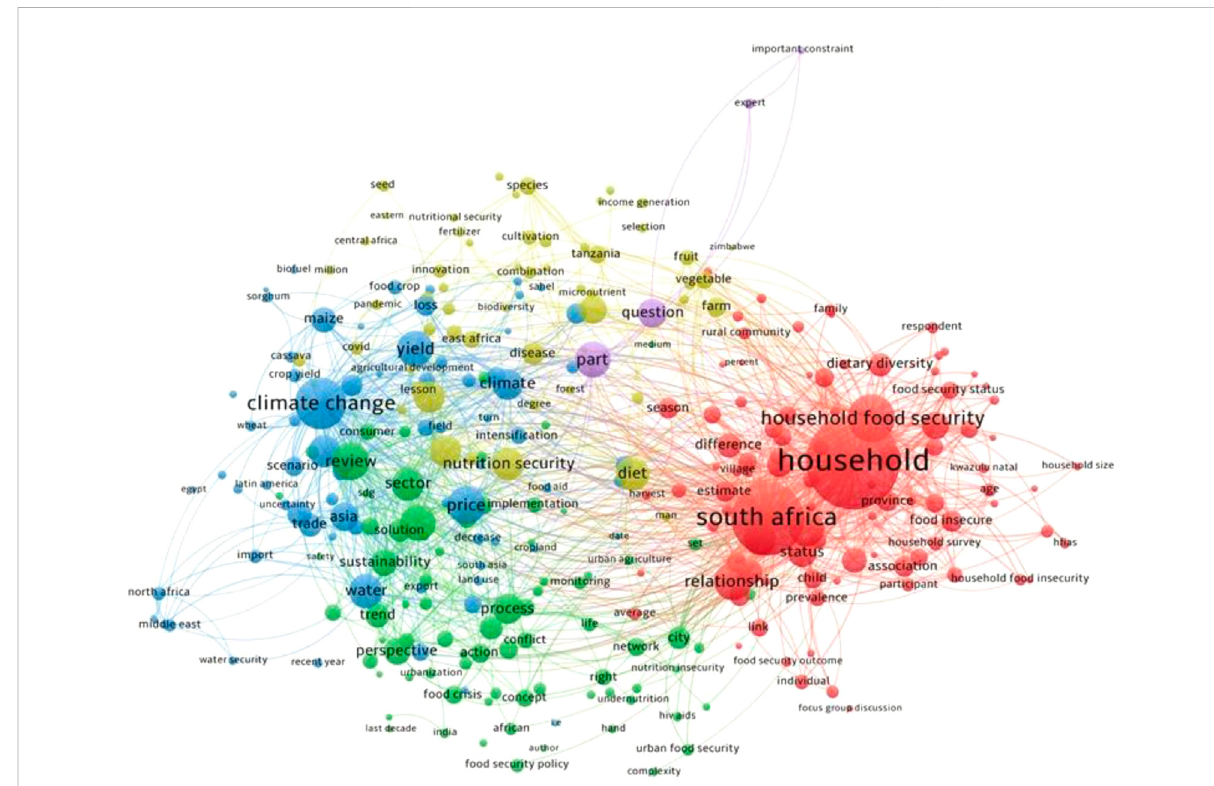
FIGURE 2 Diagram of clusters of topic terms for climate change, dryland variation, and food security nexus. The larger the node, the more frequently keywords appear in research. Lines stand for the co-citation relationship. Different colors denote research